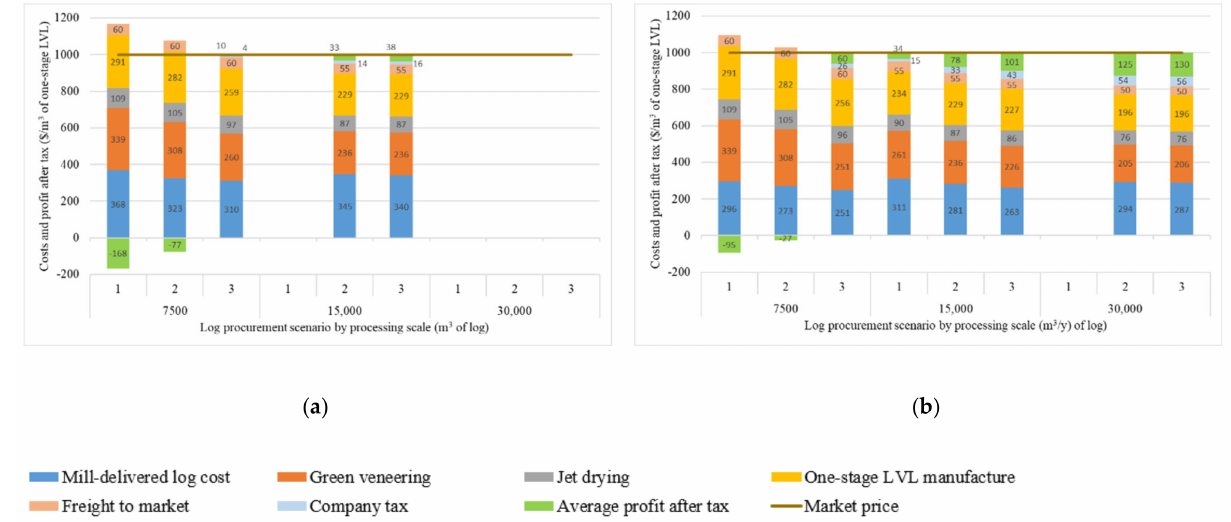
Figure 4. Average costs of production and profit after tax for integrated production of one-stage LVL.